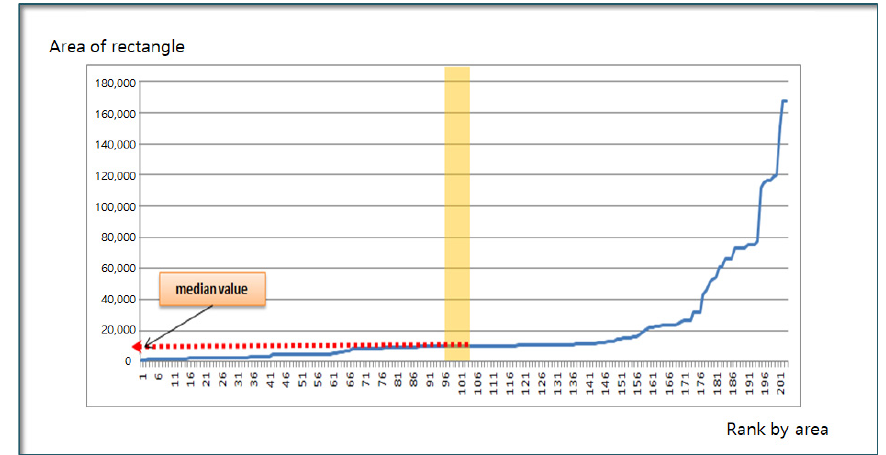
Figure 9. Choosing PV module area size by median value in a visible image.